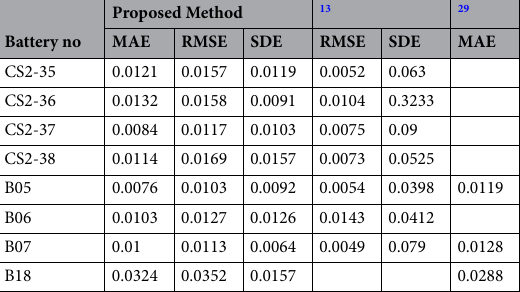
Table 5. Performance comparison with state-of-the-art